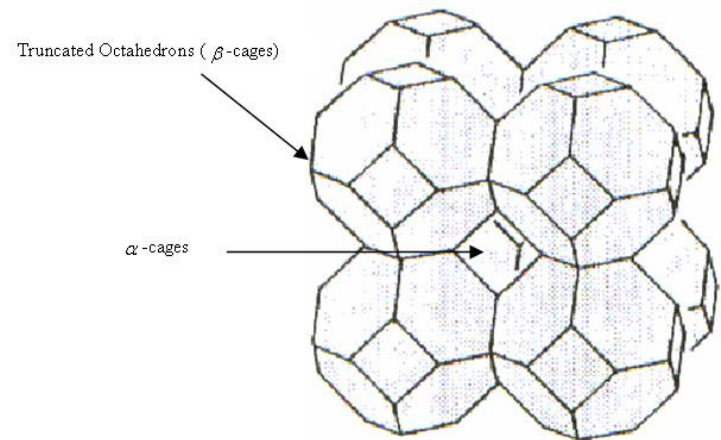
Fig. 1 Repeating unit of zeolite HS [41] Fig. 1: Repeating unit of zeolite HS